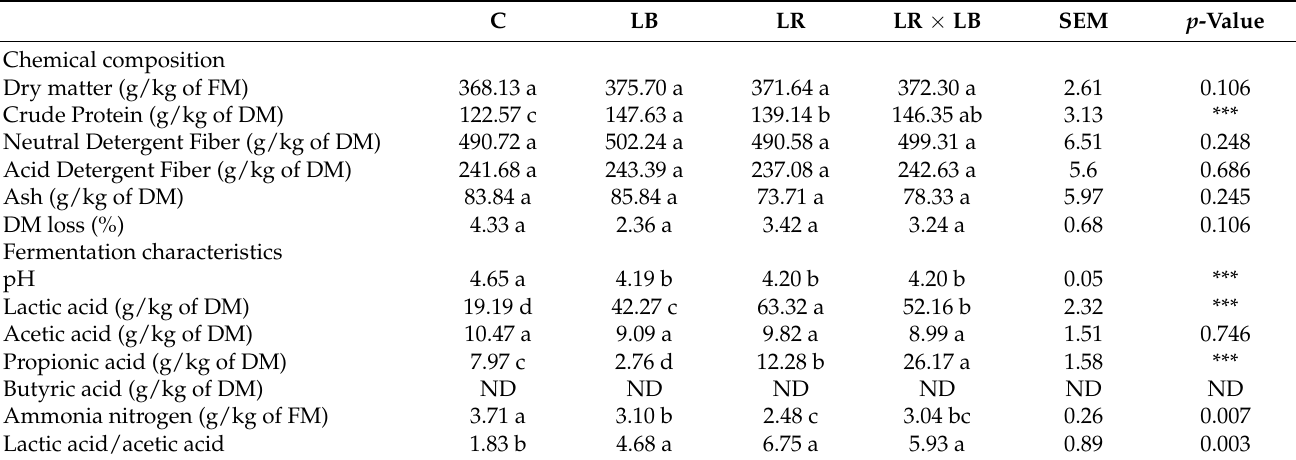
Table 2. The chemical composition and fermentation quality of paper mulberry silage.